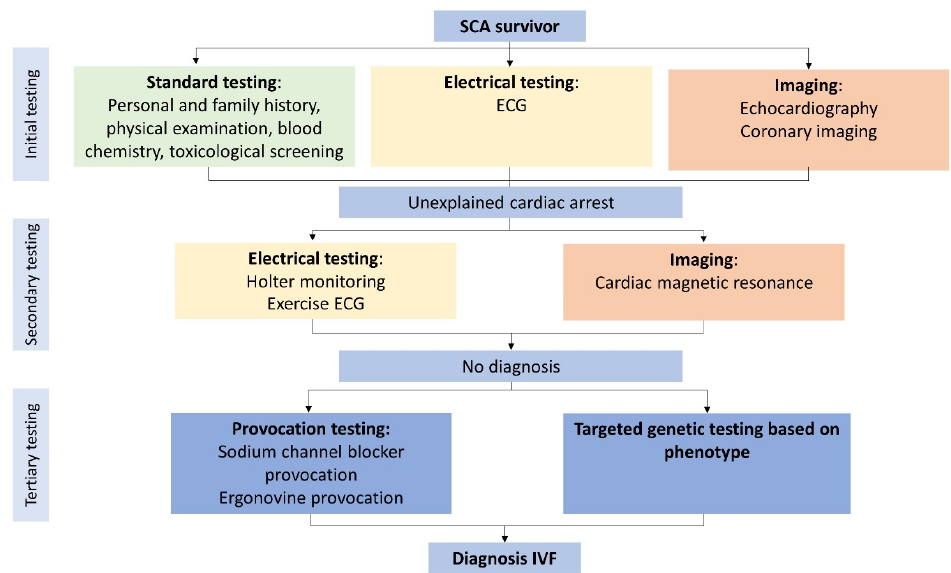
Figure 2. Minimal diagnostic tests required before diagnosing idiopathic ventricular fibrillation. Flowchart with all diagnostic tests for excluding potential causes of ventricular fibrillation. Coronary angiography can be replaced with non-invasive coronary imaging in young, low-risk patients. If a diagnosis is lacking after initial testing, it is considered an unexplained cardiac arrest. ECG: electrocardiogram; IVF: idiopathic ventricular fibrillation; SCA: sudden cardiac arrest. Adapted with permission from Visser et al. [3] and Wolters Kluwer Health, Inc., 2016. The Creative Commons license does not apply to this content. Use of the material in any format is prohibited without written permission from the publisher, Wolters Kluwer Health, Inc.